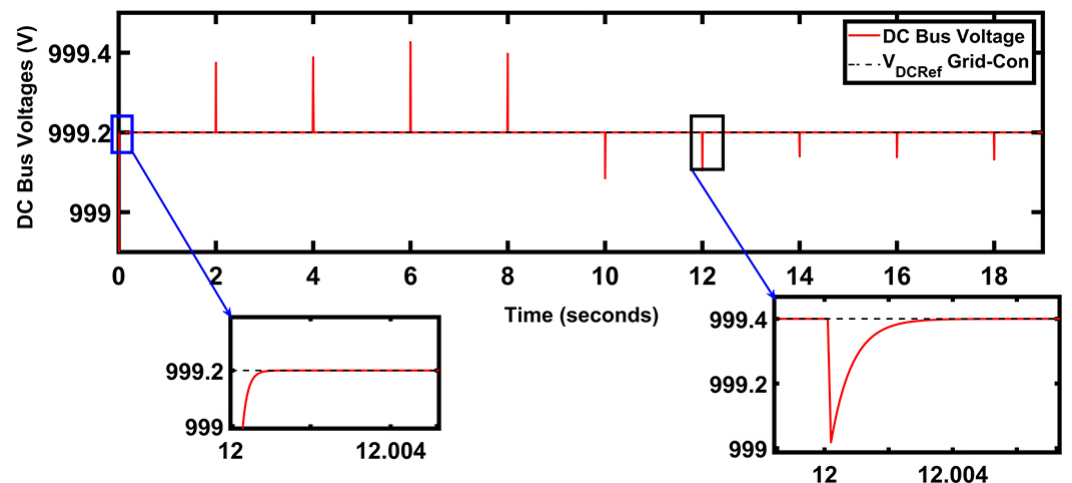
Figure 12. DC bus during grid